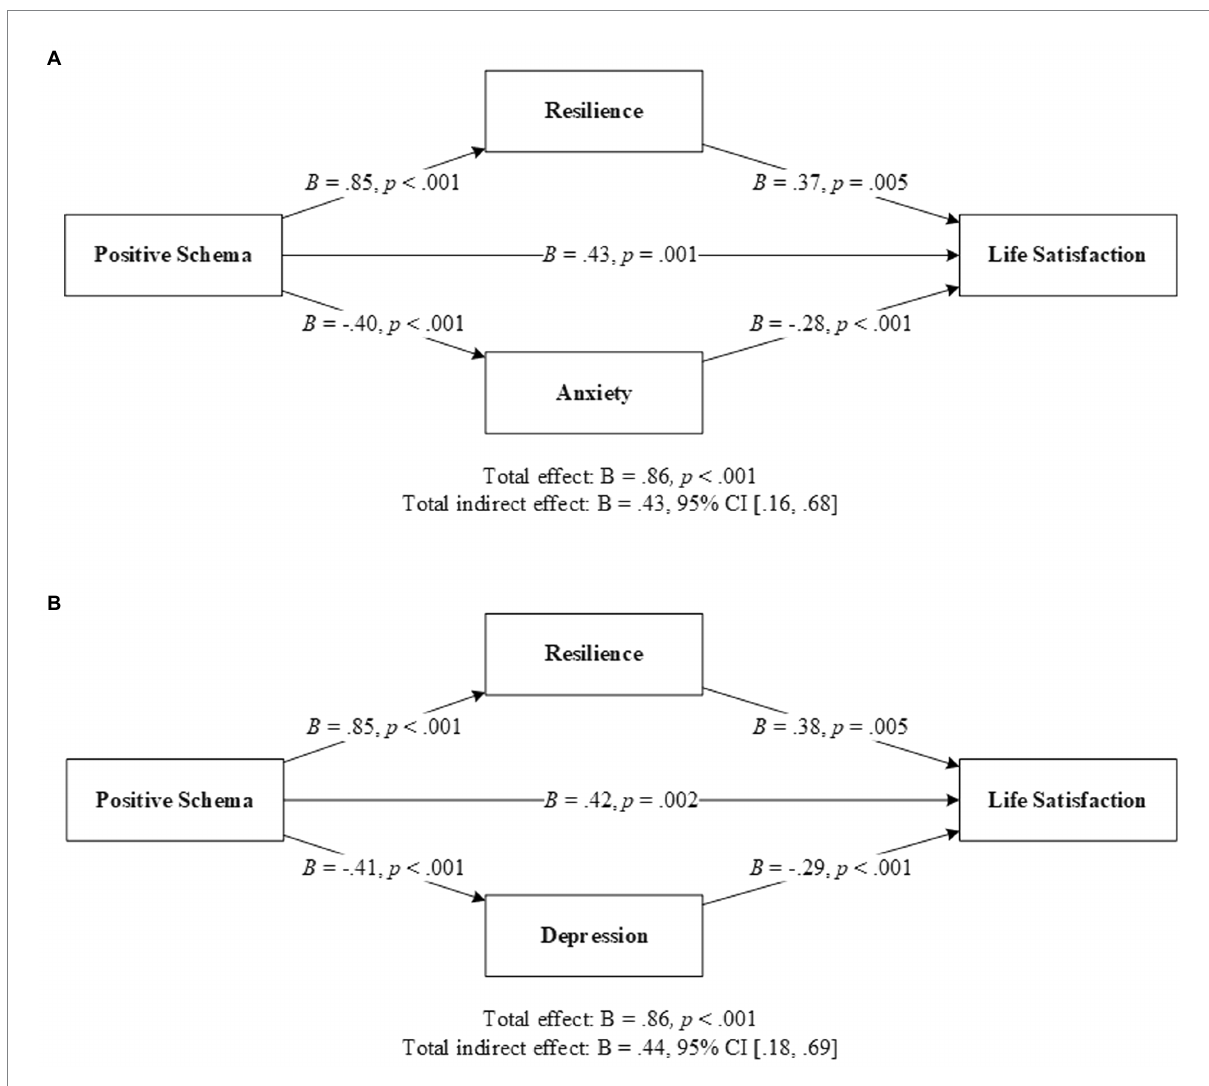
FIGURE 2 Resilience and anxiety (A) /depression (B) as parallel mediators between positive schema and life satisfaction. N = 129. CI, confidence interval. Solid lines indicate significant paths, and dotted lines indicate nonsignificant paths. Results were based on 5,000 bootstrap